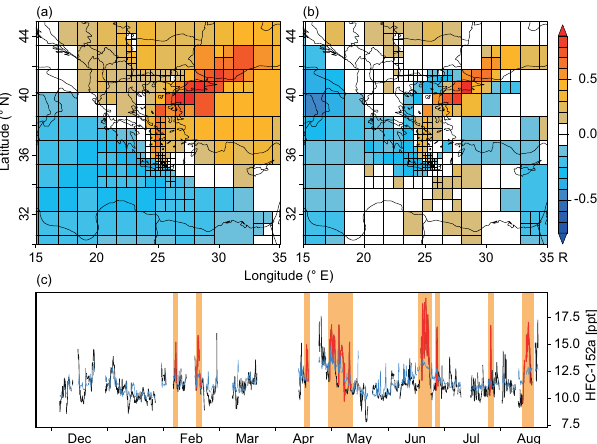
Figure 9. Spatial distribution of the Pearson correlation coefficient ( R ) for (a) the entire time series of HFC-152a observations at Fi- nokalia and the per-cell source sensitivity and for (b) the period of the pollution peaks, which are highlighted in red in (c) the observed (black) and simulated a posteriori (BASE inversion) (blue) mole fractions of